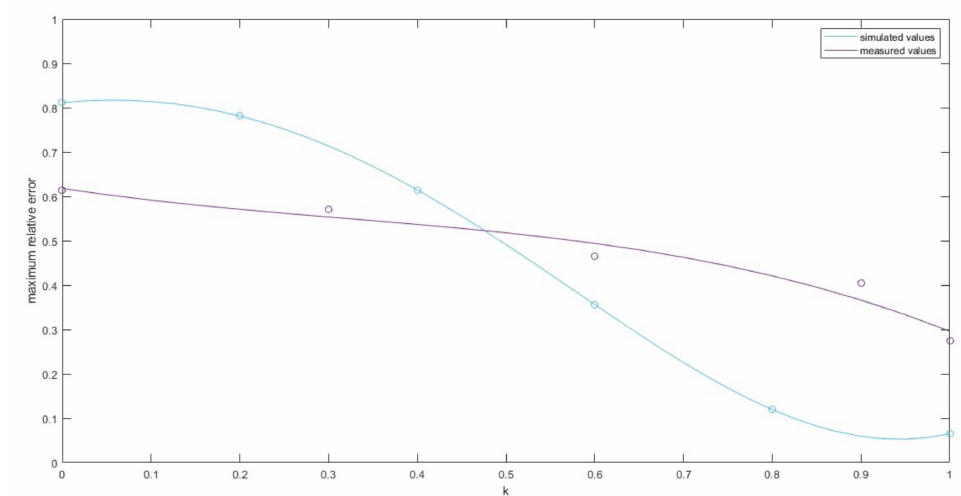
Figure 23. Comparison of simulated and measured maximum values of the relative error in the distance estimation for different k -factor